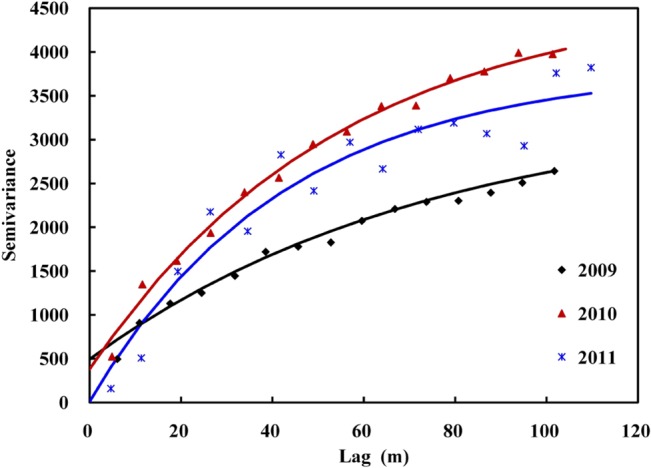
Semivariance and fitted models (solid lines) for soil ECa (mS/m) from 2009 to 2011.